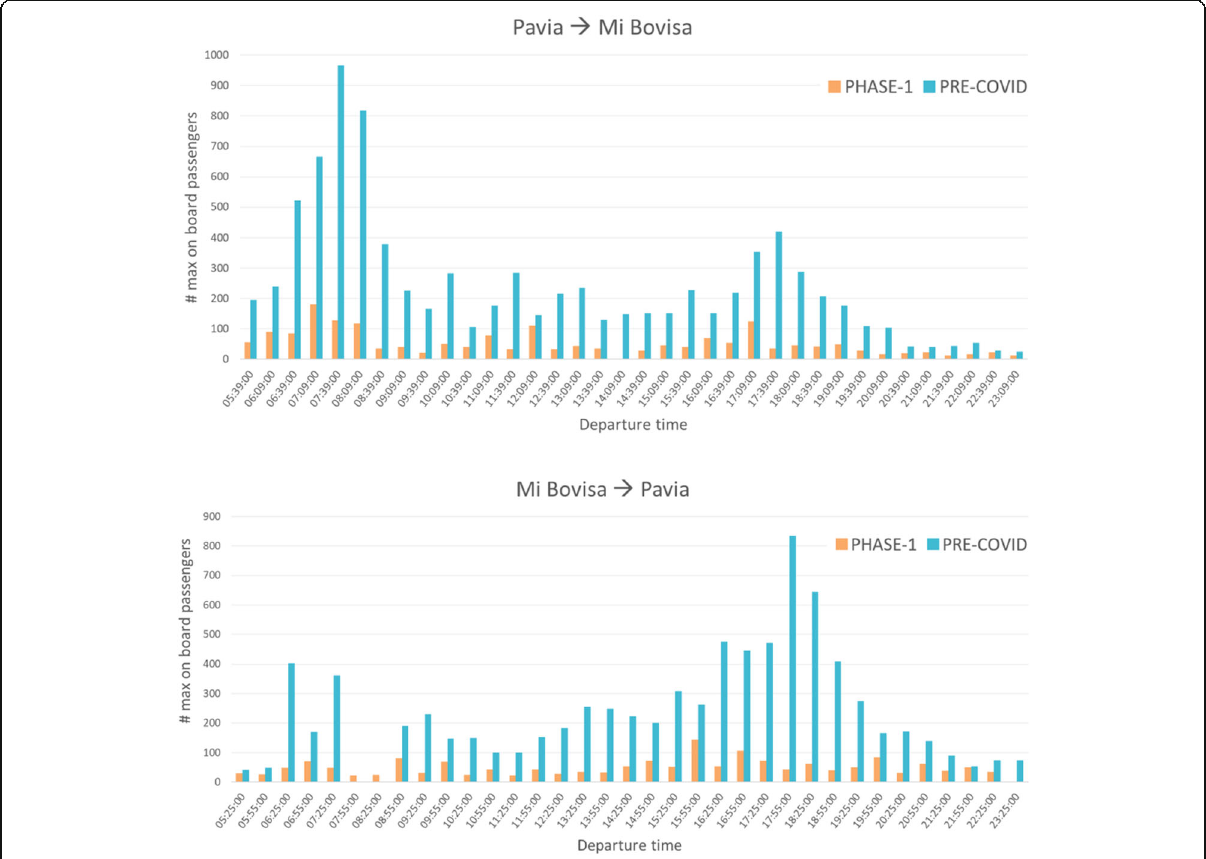
Fig. 5 Maximum number of on-board passengers for each S13 run during a working day (Pavia – Mi Bovisa and Mi Bovisa – Pavia